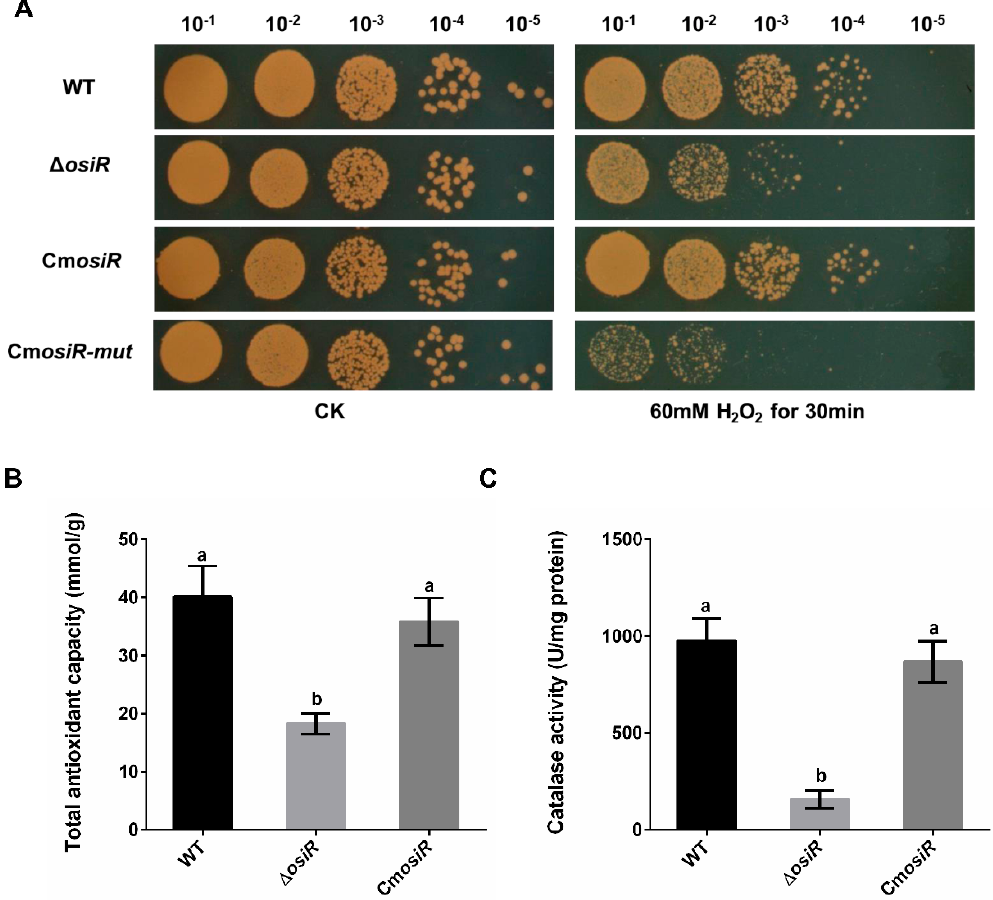
Figure 3. Deletion of osiR reduces the oxidative stress tolerance in D. radiodurans . ( A ) survival phenotype plate assay under oxidative stress conditions (one of three independent replicates). Serial 10-fold dilutions of OD-standardized cultures were spotted onto TGY plates before and after exposure to 60 mM H 2 O 2 . WT, wild type; Δ osiR , osiR deletion mutant; Cm osiR , complementary strain carrying wild-type osiR ; CmosiR-mut, complementary strain carrying mutant osiR ; CK, untreated culture control. Experiments were performed in triplicate. ( B ) and ( C ) effect of osiR mutation on the total antioxidant capacity and catalase activity of D. radiodurans . The values shown were derived from three independent experiments and error bars represent standard deviations. The statistical difference among the three samples (WT, Δ osiR , Cm osiR ) was determined by Tukey multiple comparisons ( p < 0.05); the same letter indicates that the difference is not significant and different letters indicate significant differences.